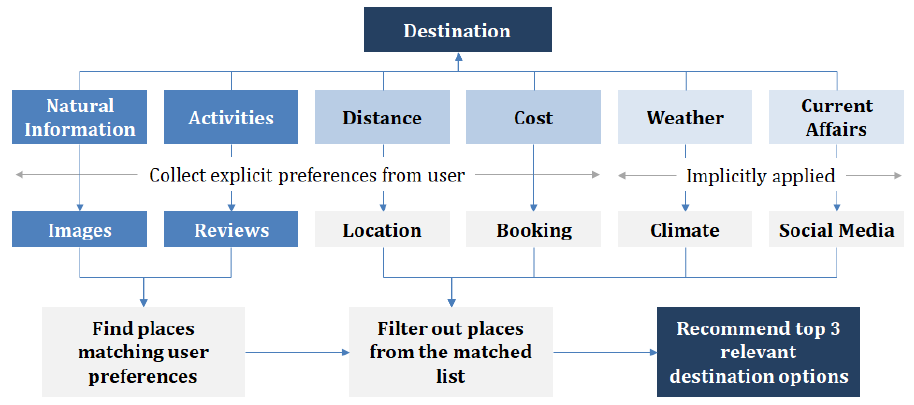
Figure 5. Overview of prototype development of thematic TRS.